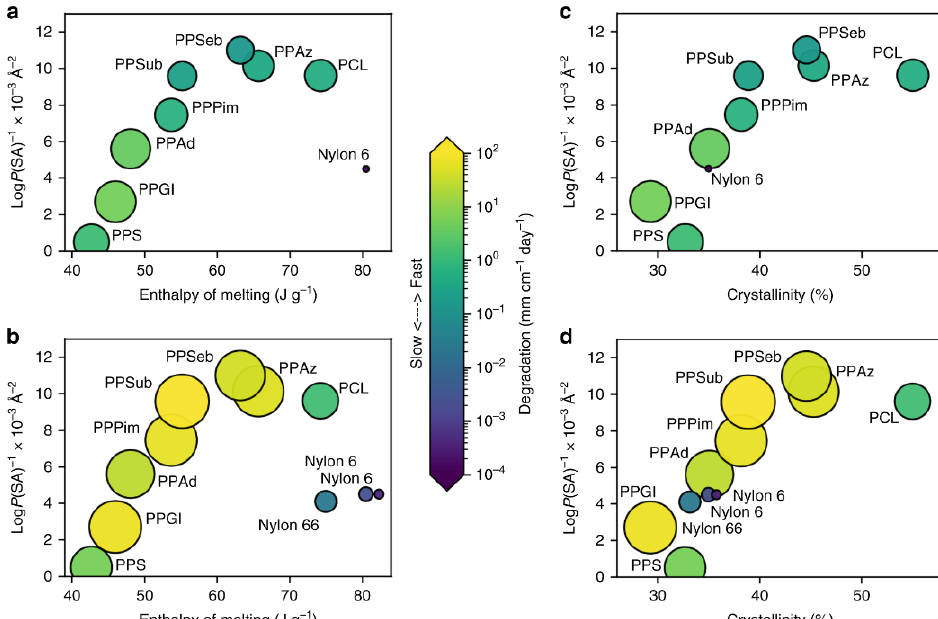
Figure 13. The influence of crystallinity and hydrophobicity on degradation [62]. The computational Log P (SA) − 1 values are plotted versus the enthalpy of melting for abiotic hydrolysis ( a ), the enthalpy of melting for biotic processes ( b ), the % crystallinity for abiotic hydrolysis ( c ), the % crystallinity for biotic processes ( d ).The size of circles and colour is equivalent to surface erosion (in mg cm − 2 day − 1 ) in artificial seawater.